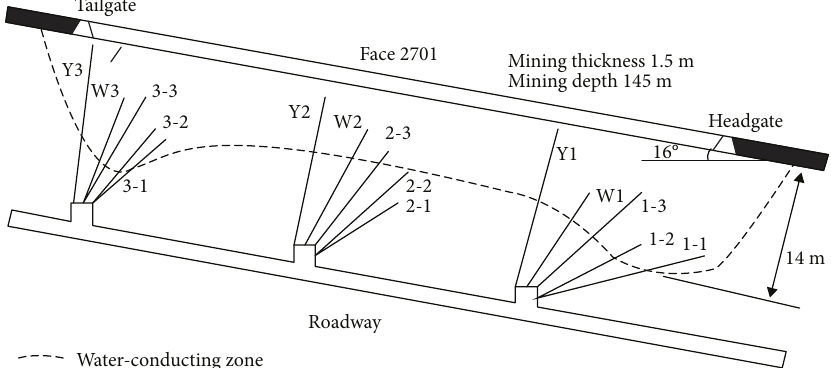
Figure 11: Observed pro fi le of the water-conducting failure zone in the fl oor for slightly inclined coal seam ( 0 ° < α < 25 ° ) in Fengfeng coal mines, Hebei Province [5].